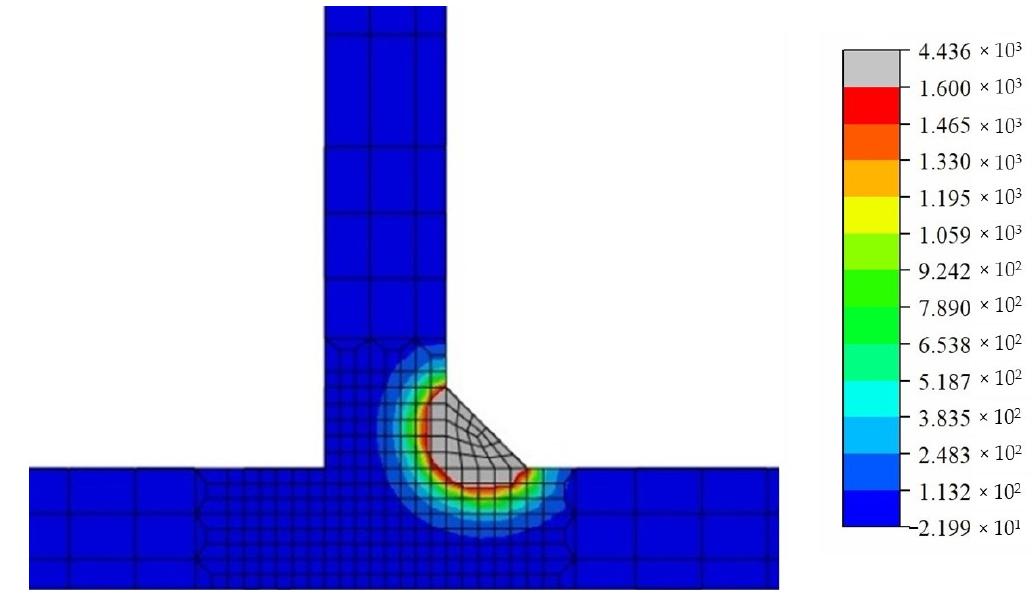
Figure 4. Molten zone of the weld (unit: °C).